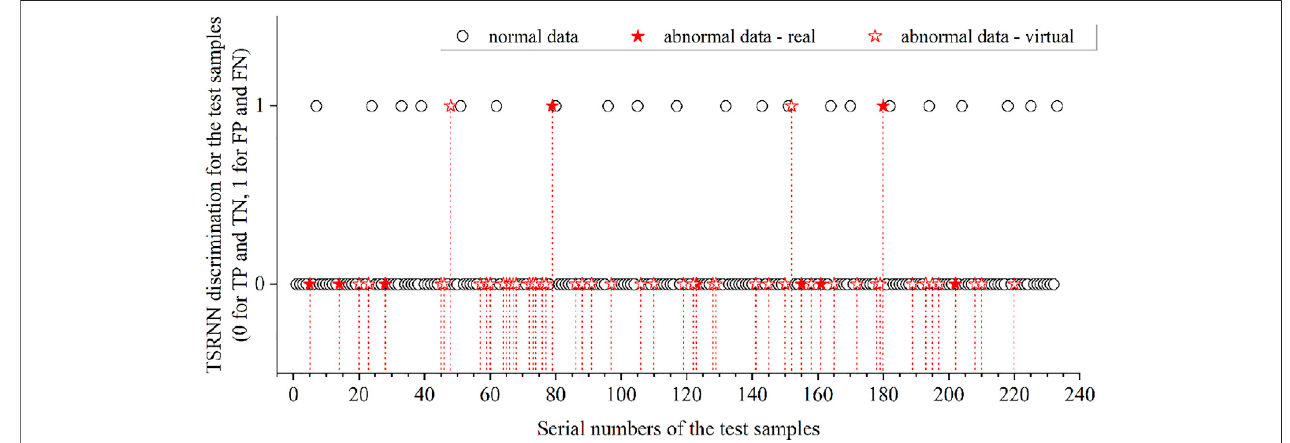
FIGURE 7 | Discrimination for each test sample by the optimal TSRNN model.